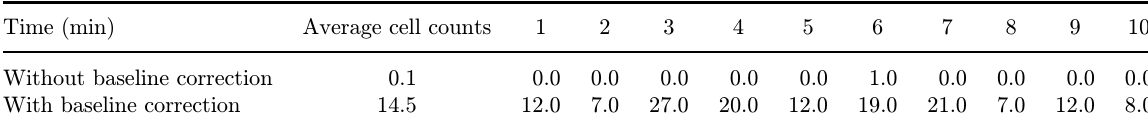
Without baseline correction